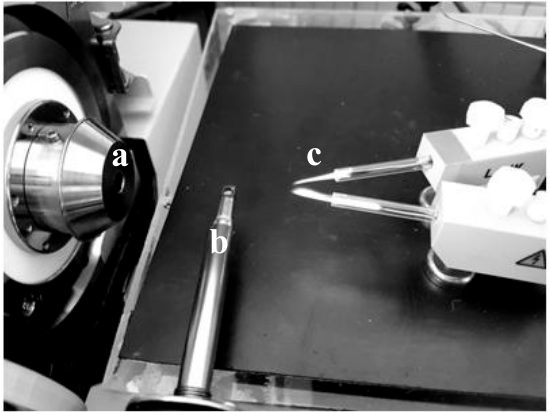
Figure 13. The system used to carry out the experiment: ( a ) mass spectrometer inlet, ( b ) heating system, ( c ) FAPA-ion source.